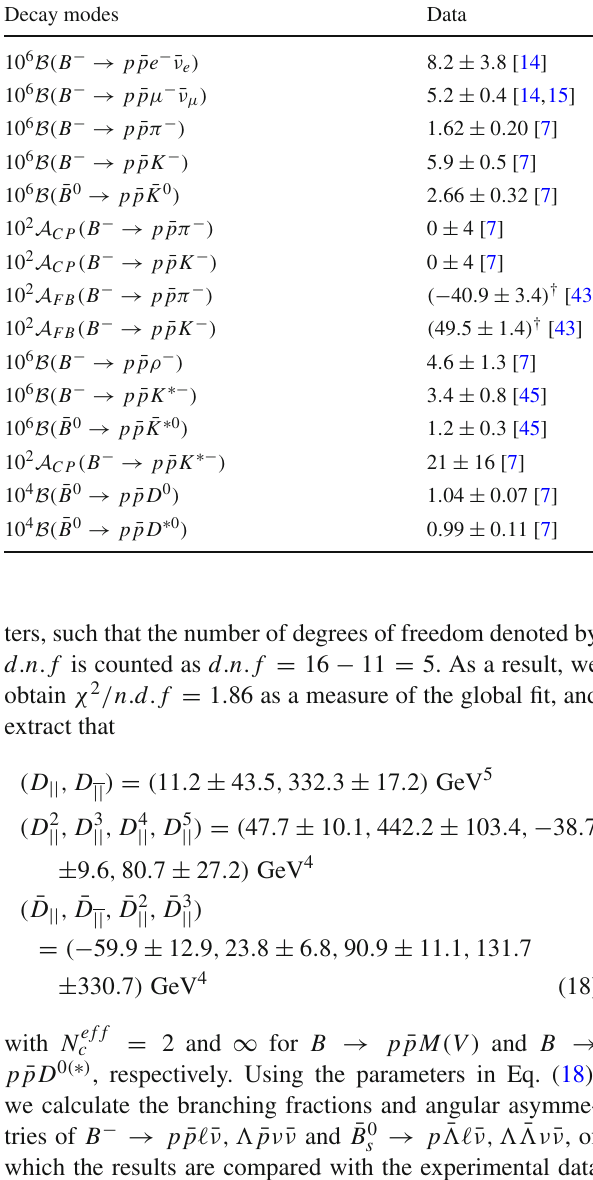
Table 2 Experimental data for the B − → p ¯ p (cid:9) − ν (cid:9) and B → p ¯ pM ( c ) decays, where the notation † for A FB denotes the contribution from m and LHCb data in Eq.